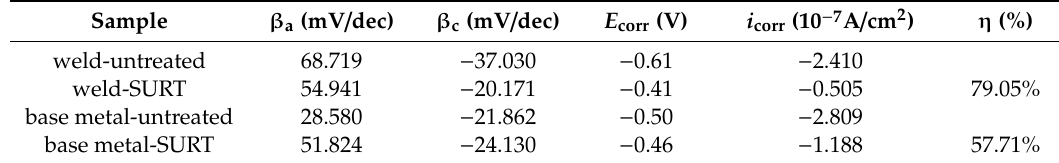
Table 4. Corrosion parameters of the samples derived from Tafel polarization